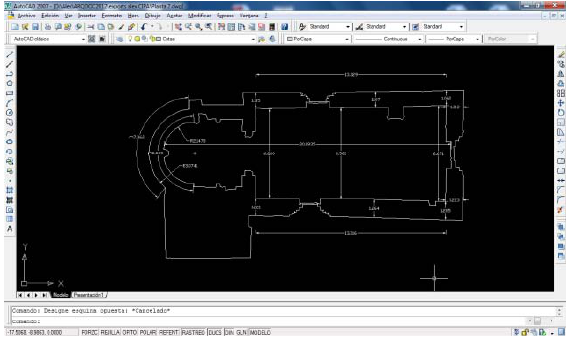
Figure 5. Section of floor plan